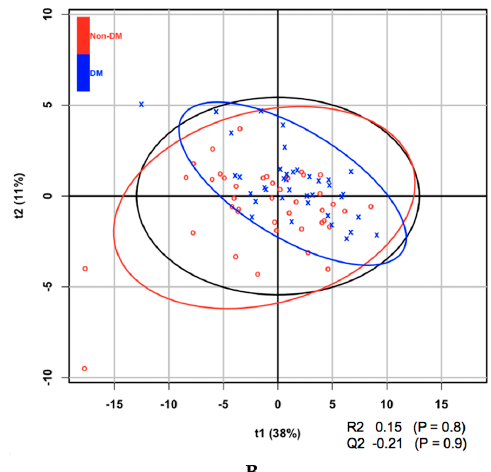
Figure 1. ( A ) Partial least squares discriminant analysis (PLS-DA) score plot of amino acids at baseline for the development of diabetes within 5 years. ( B ) PLS-DA score plot of lysophosphatidylcholines (LPCs) at baseline for the development of diabetes within 5 years.